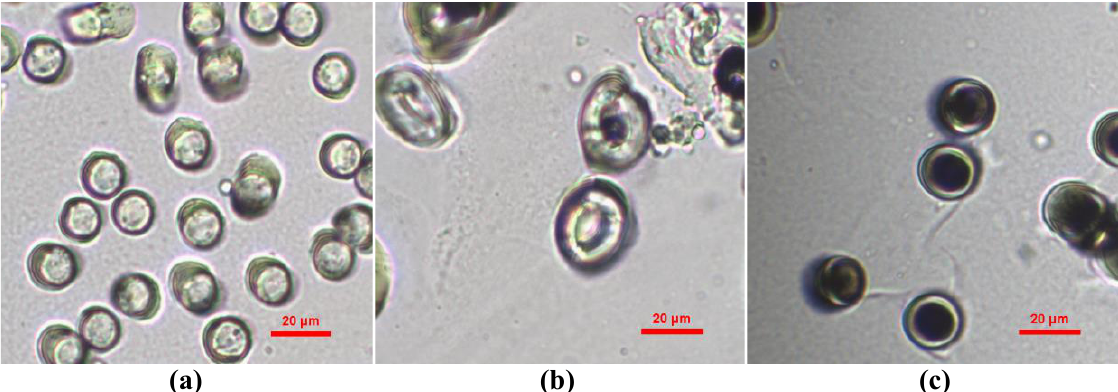
Figure 1. Cross-sectional images of fibers. ( a ) Staple fiber; ( b ) hollow fiber; ( c ) bicomponent fiber [9].